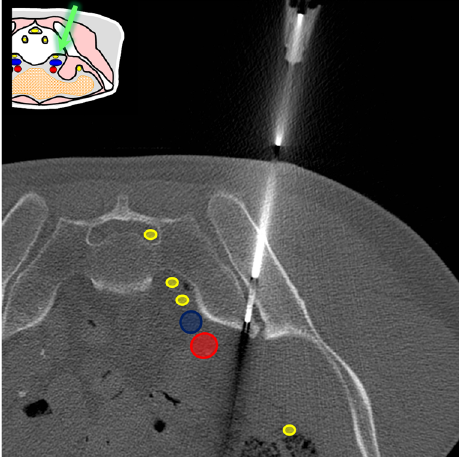
Fig. 8 A 59-year-old man presenting with unilateral sacroiliitis, negative blood cultures and negative sacroiliac joint fluid aspiration. Axial CT shows the 11-G bone biopsy needle through the sacroiliac joint. This approach was planned to allow sampling of both the joint space and subchondral bone B sandwich technique ^ and increase biopsy yield